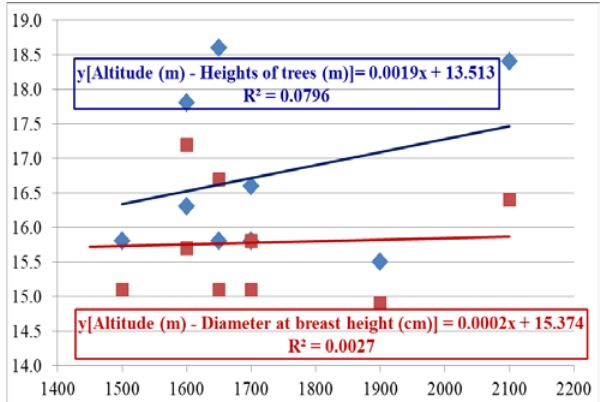
Fig. 5. Equation of regression between altitude (in ‘m’, O-X axe) and height of trees (with blue, in ‘m’, O-Y axe), respectively diameter at breast height of the trees (with red, in ‘cm’, O-Y axe) for the spruce